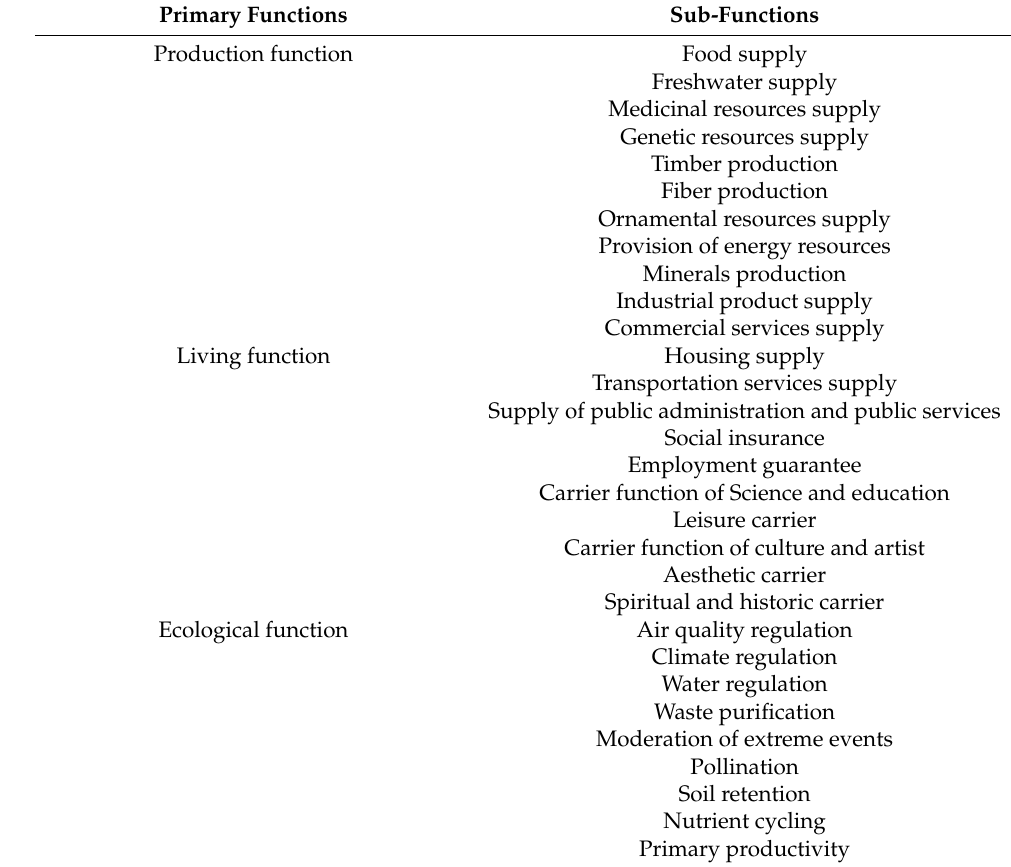
Figure 1. The concept of land resources carrying capacity. Table 1. The comprehensive classification of land resources